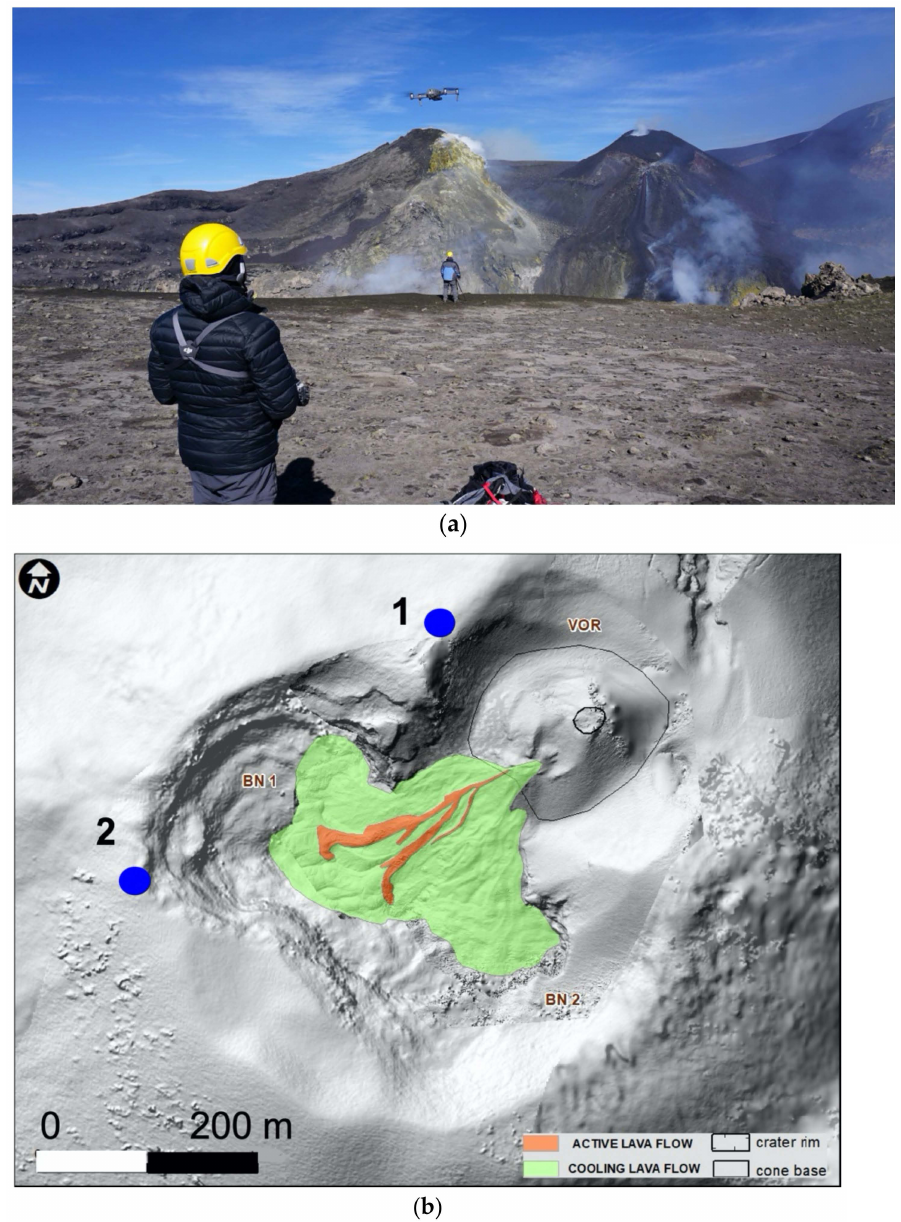
Figure 2. ( a ) Researcher monitoring the activity on 25 February 2020; ( b ) shaded relief of Etna summit craters; blue dots indicate camera